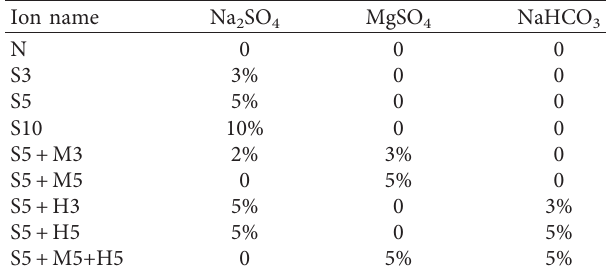
Table 3: Ratio of salt